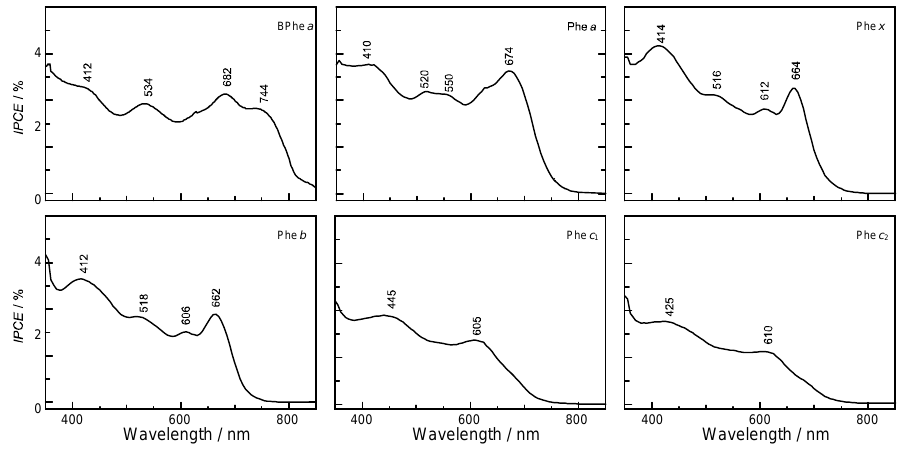
Figure 33. The IPCE profiles of solar cells using BPhe a , Phe a , Phe x , Phe b , Phe c as sensitizers (reprinted with permission from [20] © 2008, American Phe c 2